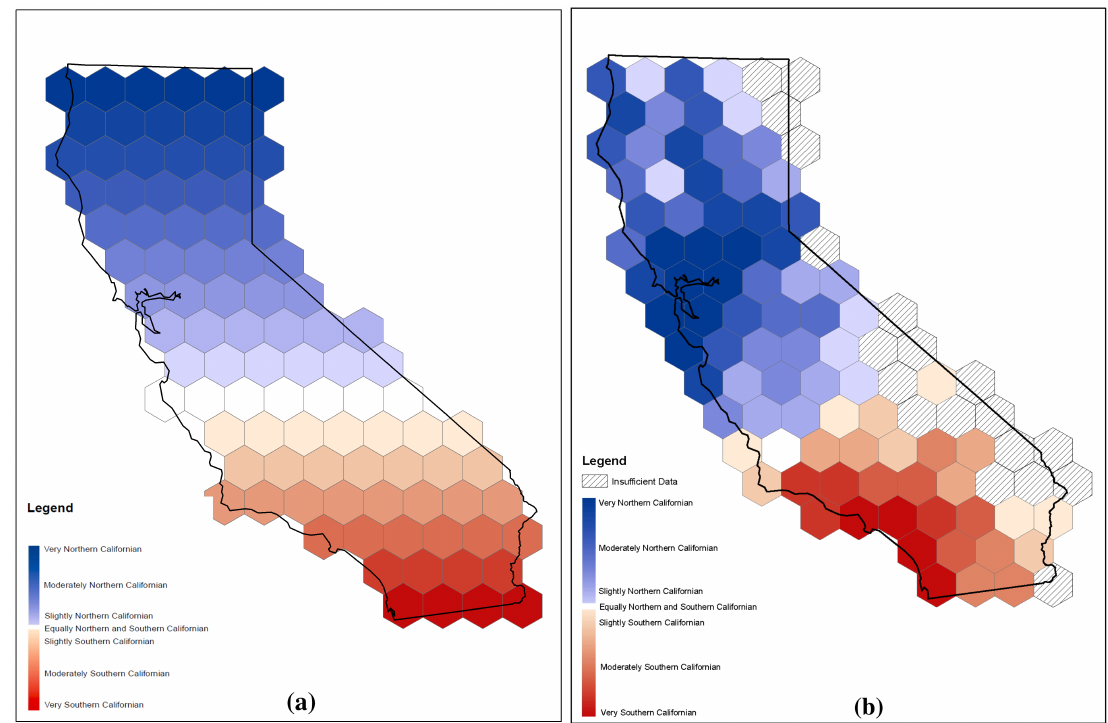
Figure 6. An example of ORO: northern and southern California. ( a ) Vague regions purely based on spatial relations; ( b ) Vague cognitive regions using social media